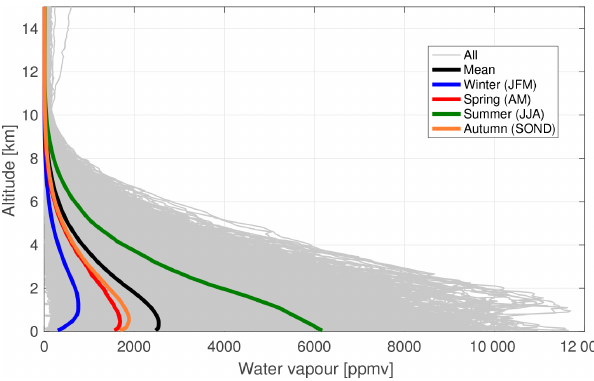
Figure 1. Eureka radiosonde water vapour profiles (August 2006